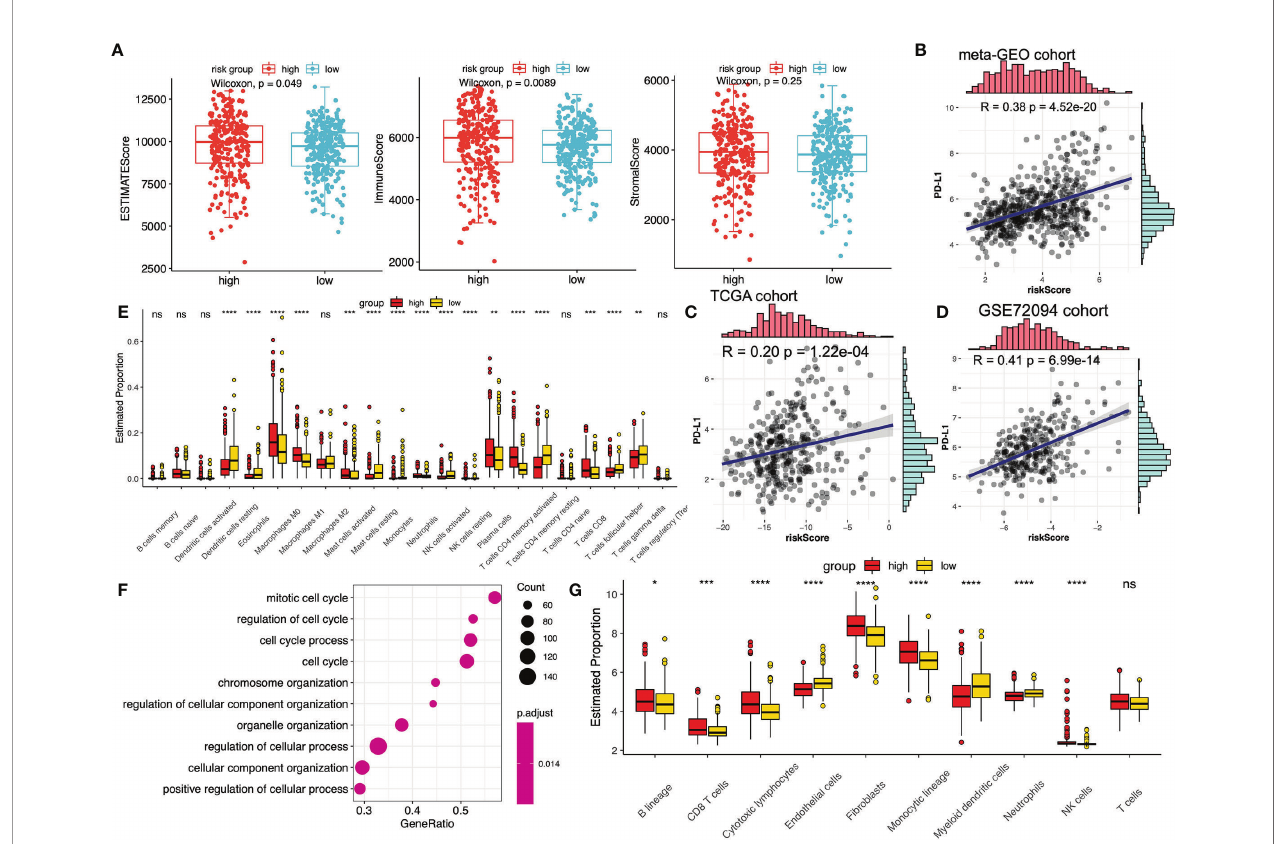
FIGURE 5 | The relationship between m 6 A-predictive score and immune in fi ltration. (A) Distribution of different immune scores (ESTIMATEScore, ImmuneScore and StromalScore) in low and high m 6 A-score groups. (B – D) The correlation analysis of PD-L1 expression levels and m 6 A-predictive score via Spearman correlation method in meta-GEO cohort, TCGA cohort and GSE72094 cohort. (E) The estimated fraction of different immune in fi ltrating cells calculated by CIBERSORT algorithm in different m 6 A-score groups (*P < 0.05; **P < 0.01; ***P < 0.001; ****P < 0.0001). (F) GSEA enrichment analysis (GO) of the top differentially expressed genes in the group with a high m 6 A-predictive score. (G) The estimated fraction of different immune in fi ltrating cells calculated by MCPcounter algorithm in different m 6 A-score groups. ns, not signi fi